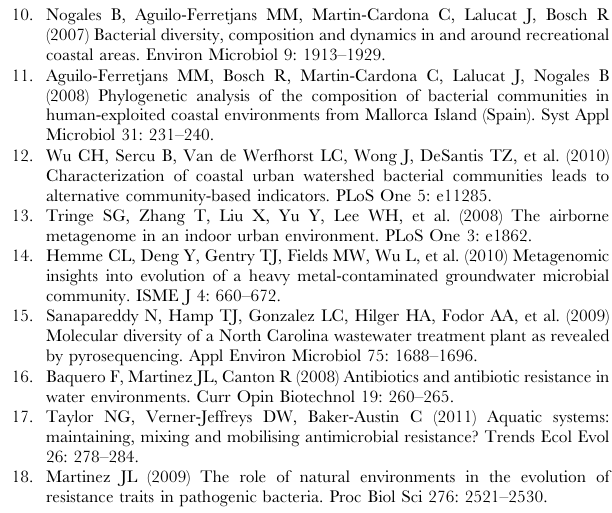
Figure S3 Abundance of antibiotic resistance gene sequences in environmental metagenomes with varying